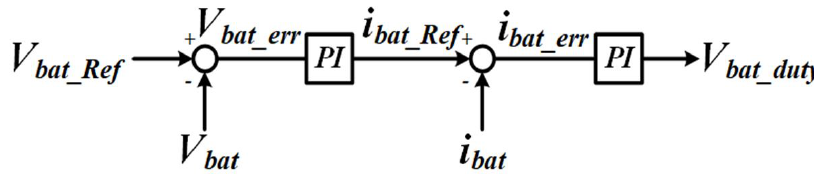
Figure 13. Control block diagram of the battery charger converter.